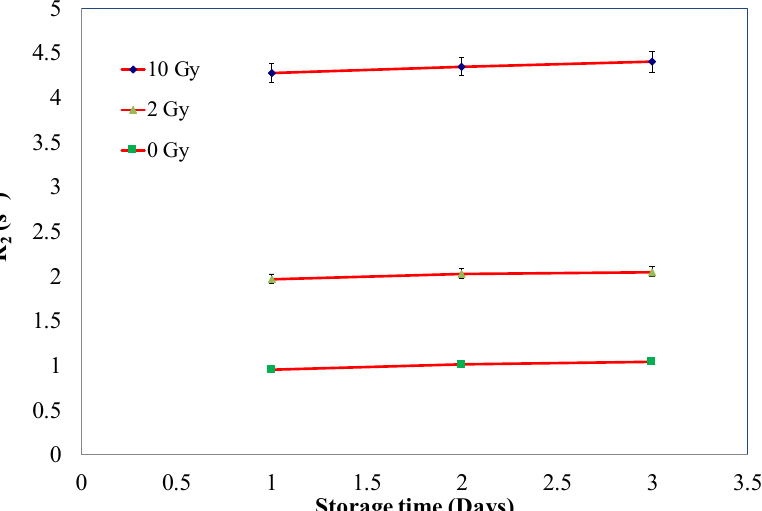
Figure 3. R 2 of gel with 500 mM CaCl 2 irradiated at different doses as a function of storage time. Error bars are the 2 σ of R 2 values.